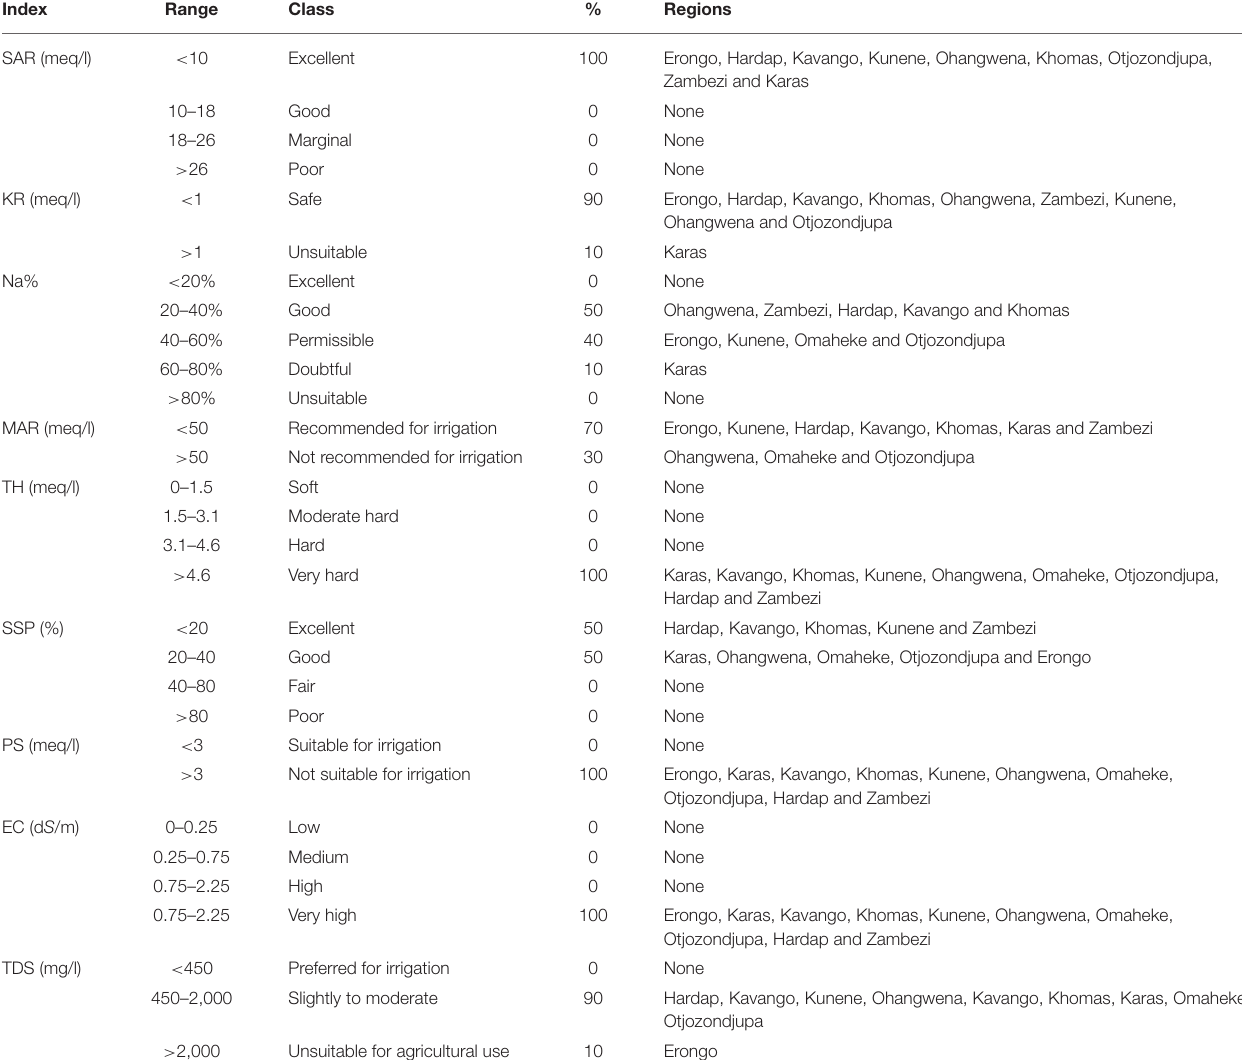
TABLE 10 | Classification of groundwater quality value for irrigation in 10